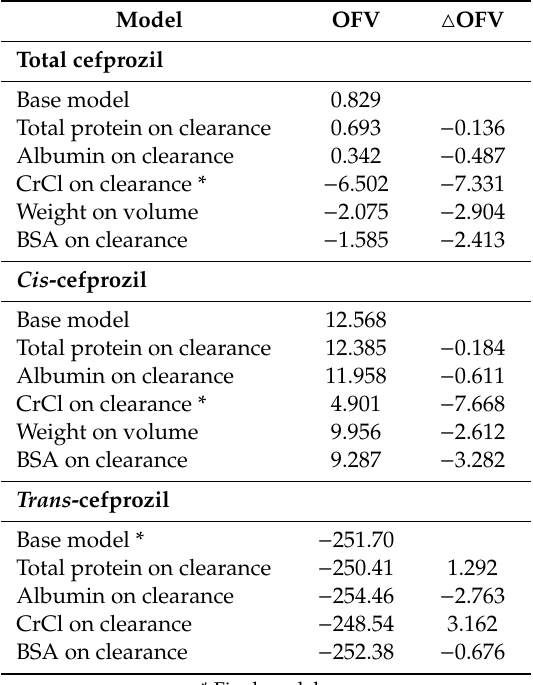
Table 3. Stepwise search for